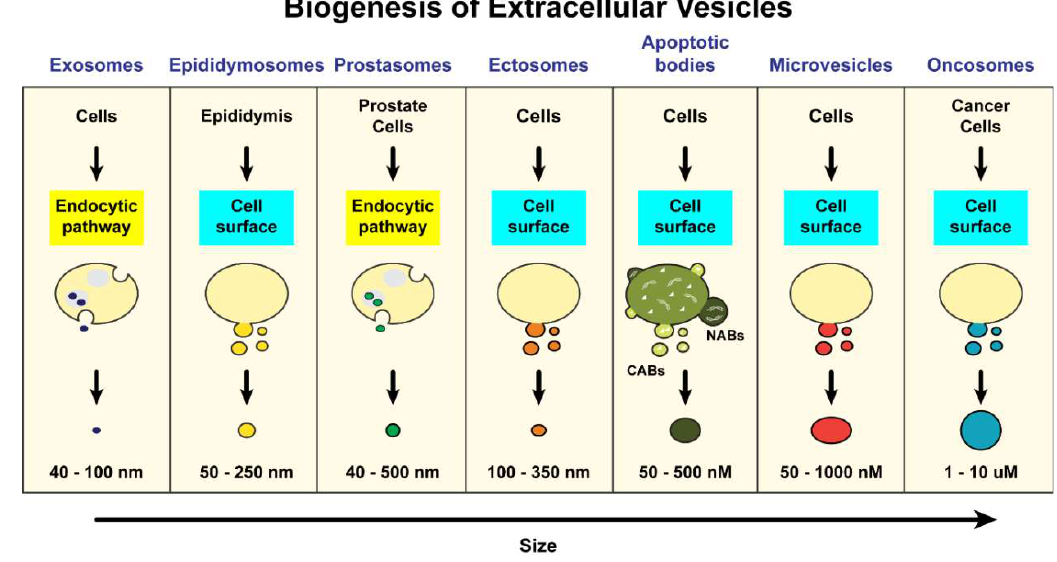
Figure 1. Origin and biogenesis of di ff erent groups of extracellular vesicles. EVs are arranged by increasing size from left to right. Left- Exosomes, are secreted by a variety of cell types and are formed in MVBs via the endocytic pathway. Epididymosomes and Prostasomes are EVs found in seminal fluid. Epididymosomes are secreted by cells in the epididymis through budding from the plasma membrane and prostasomes are secreted by epithelial cells of the prostate gland via endosome formation and release into the prostatic fluid. Ectosomes, like exosomes, are secreted by a variety of cell types but unlike exosomes, they are formed via budding from the plasma membrane. Apoptotic bodies are the results of blebs arising from disassembly of apoptotic cells. They are subdivided into two groups, depending on their contents: nuclear (DNA carrying) apoptotic bodes (NABs) and cytoplasmic apoptotic bodies (CABs). Microvesicles are larger in size and are also secreted by a variety of cells. They are also generated by outward budding from the plasma membrane. Oncosomes are much larger than most extracellular vesicles are secreted by various cancer cells via membrane shedding. 70 Exosomes are basically nano-sized (ranging from 40–100 nm) intercellular communication